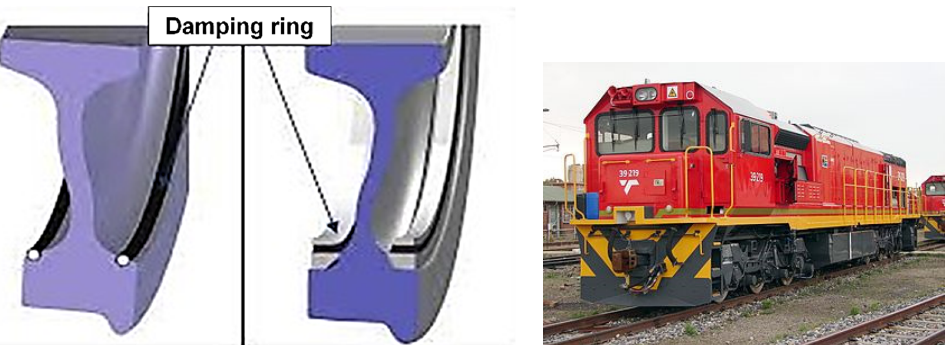
Figure 1. Damping ring under the rim of both sides of the wheel [19].